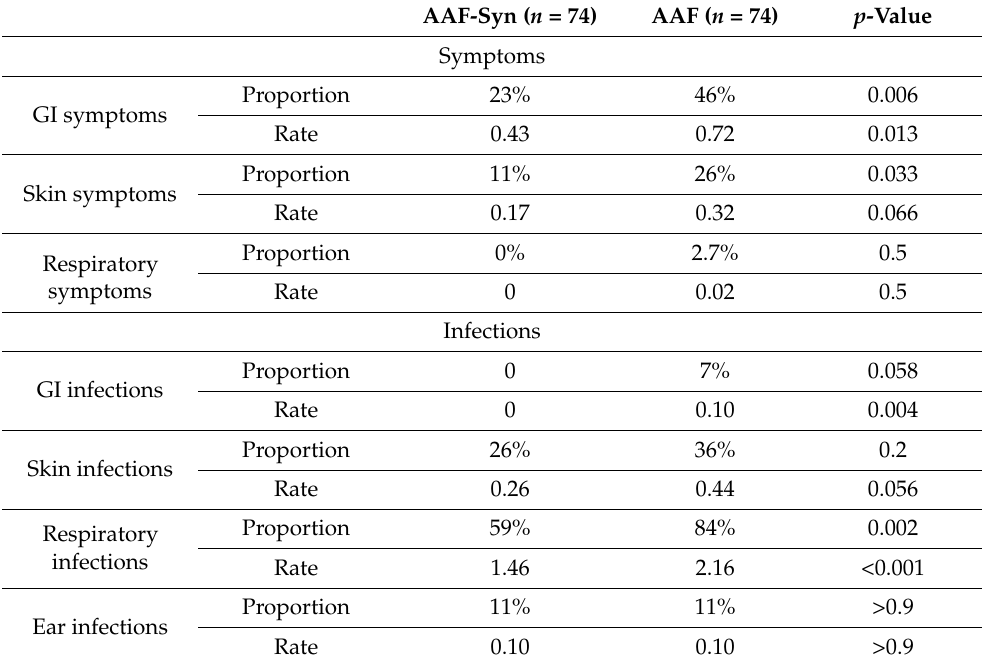
Table 4. Incidence of symptoms and infections with AAF-Syn vs. AAF as the proportion of infants affected and rate per